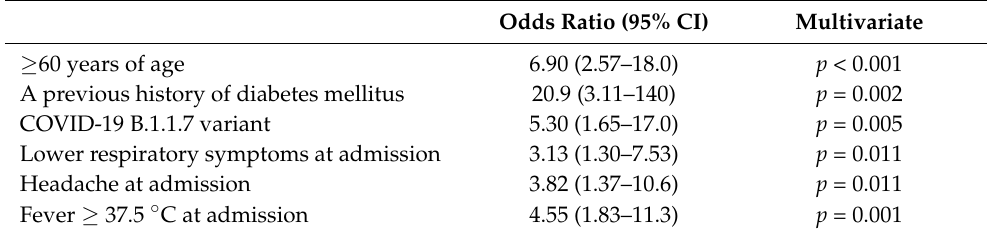
Table 4. Multivariate analysis with the adjusted odds ratio of risk factors for therapeutic intervention of remdesivir among mild to moderate COVID-19 hospitalized